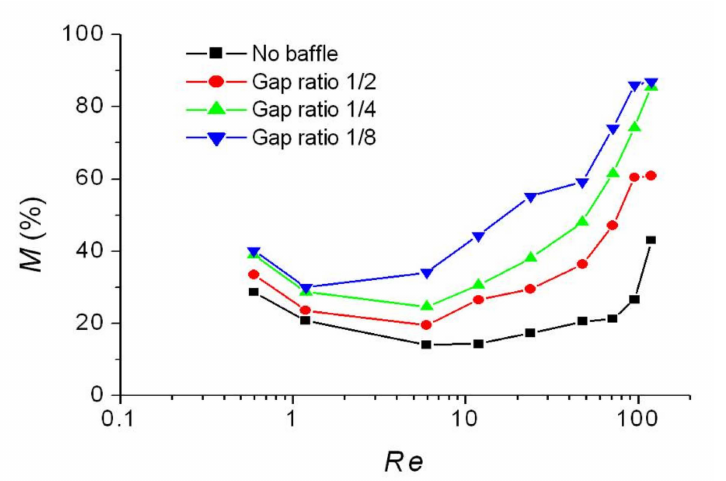
Figure 19. Mixing efficiency of the modified rhombic micromixer with different gap ratios as a function of Reynolds number.